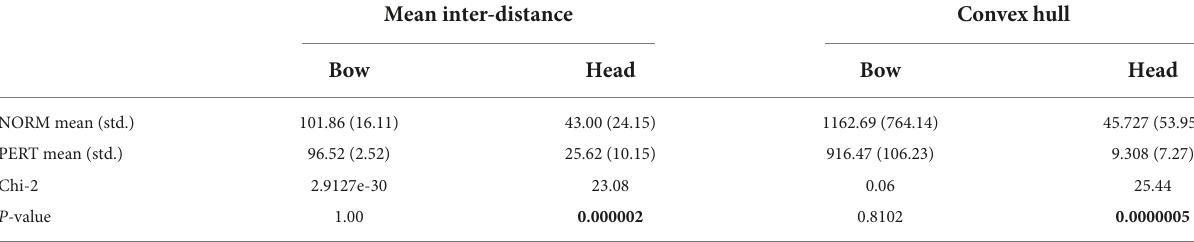
TABLE 1 Mean inter-distance (in mm) between positional datapoint and convex hull volume (in cm 3 ) indicating head and bow trajectories, compared across experimental conditions. Mean inter-distance Convex hull Bow Head Bow Head NORM mean (std.) 101.86 (16.11) PERT mean